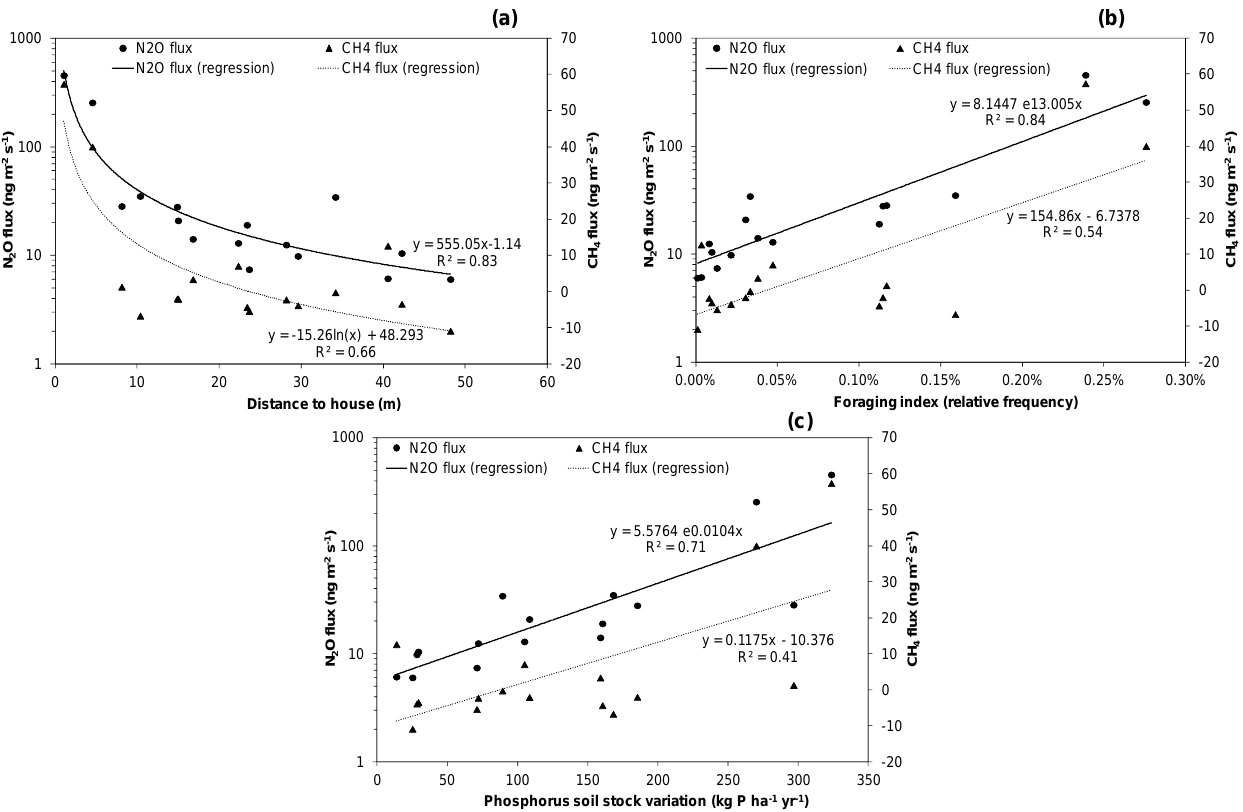
Fig. 7. Relationships between average measured N 2 O and CH 4 chamber fluxes and control variables: (a) Distance to broiler house. (b) Foraging index. (c) Annual variation of phosphorus soil stock. Each datapoint represents the mean measured flux at one chamber location on the plot.